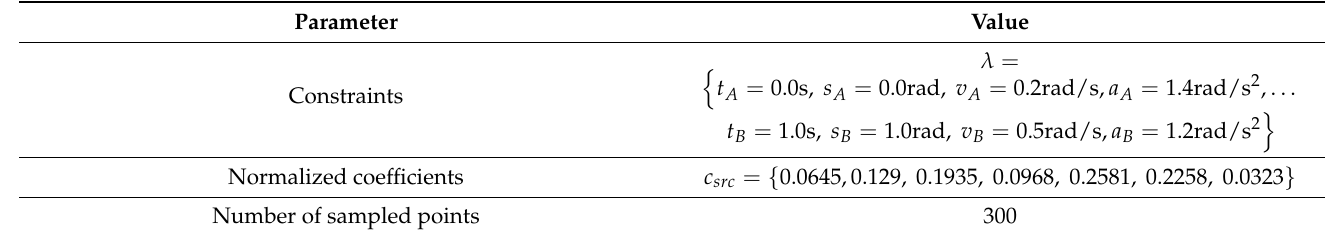
Figure 8. Application of the method to a simulated case, with random disturbance added to acceleration. (Black: acceleration of the starting step of the identification process; red: displacement; green: velocity; blue: acceleration, after the identification). Table 1. Values of the main parameters for the law of motion of the simulated